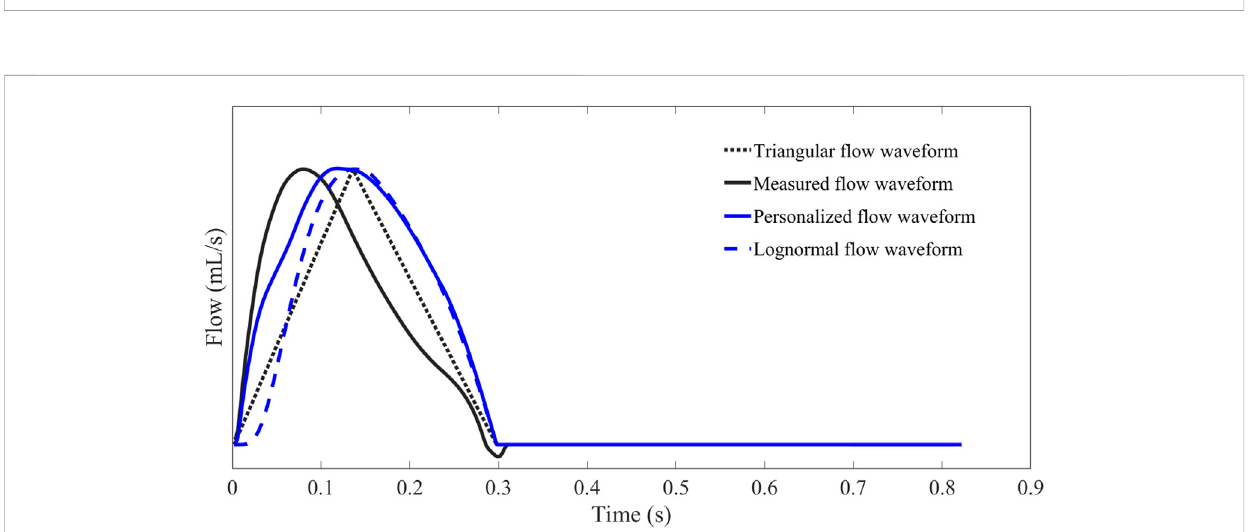
FIGURE 8 Comparison and contrast of fl ow waveforms obtained by Hermite interpolation function estimation, measurement, triangular estimation, and lognormal approximation.